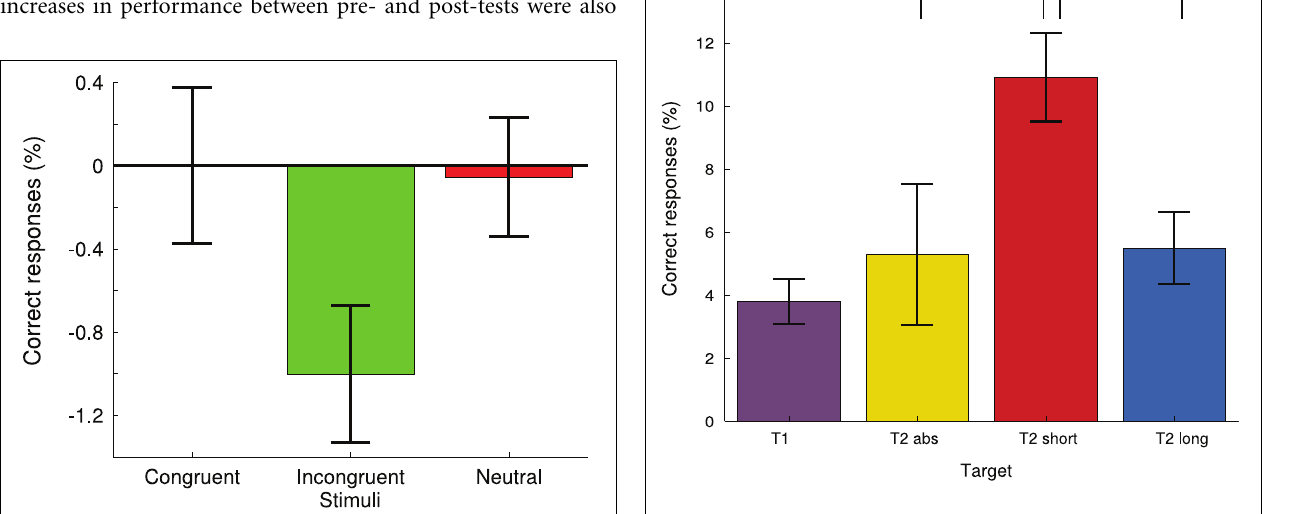
FIGURE 3 | Mean accuracy improvement for each target type between pre and post test in the attentional blink task. Standard error of the mean are shown for each condition. ∗∗ indicates p < 0 . 005 and ∗∗∗ indicates p < 0 .